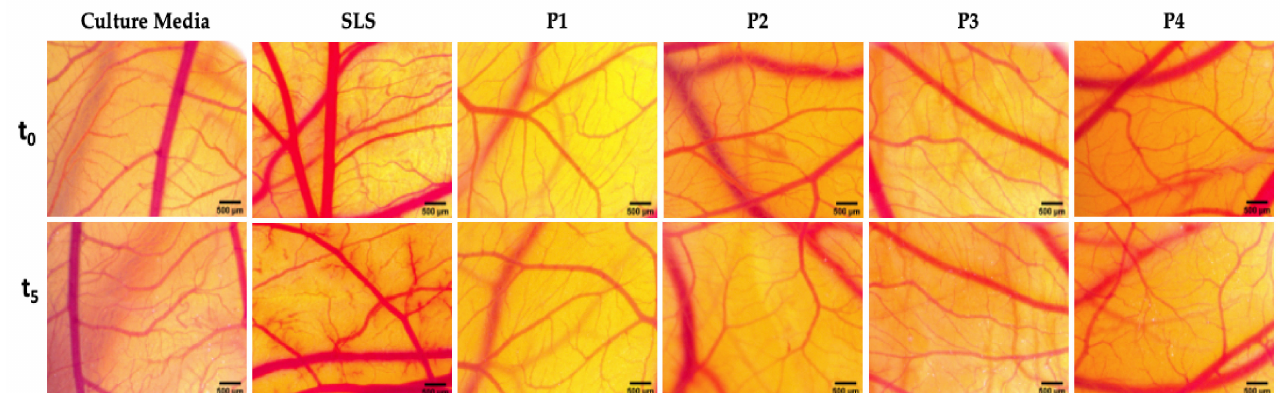
Figure 5. Stereomicroscope images of the CAMs inoculated with controls (culture media used as negative control and sodium lauryl sulfate—SLS 0.5% was used as positive control) and test dental ceramics (P1, P2, P3, P4). The pictures were taken before the application (t 0 ) and after 5 min of contact with the test compounds (t 5 ). Scale bars represent 500 µ m.